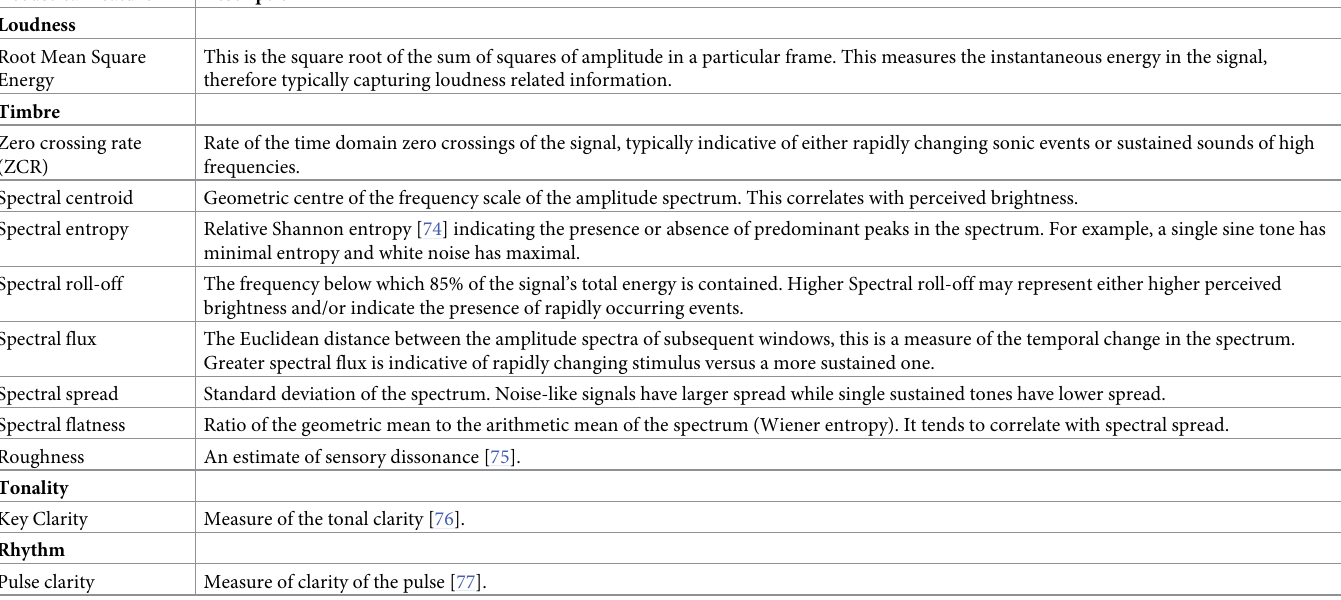
Table 1. Overview and description of acoustic features